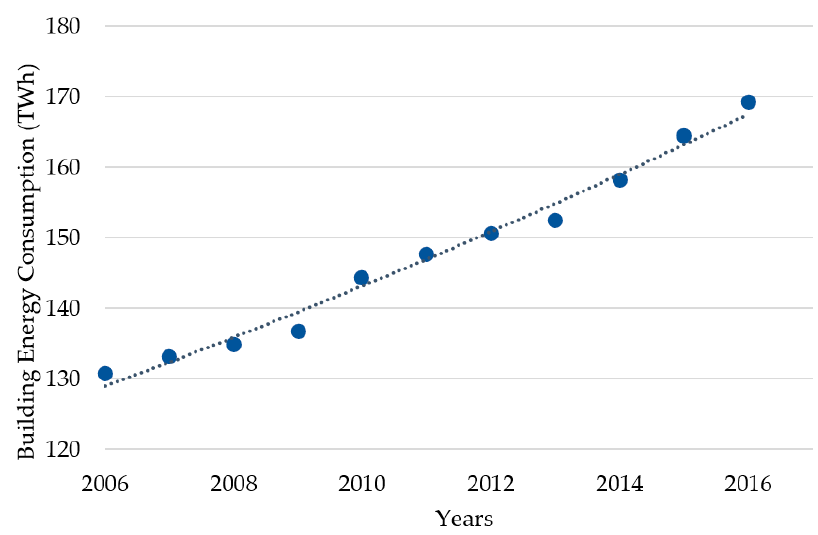
Figure 16. Building energy consumption in Bangladesh rising linearly with a rate of +7.8% annually over the years 2006 to 2016